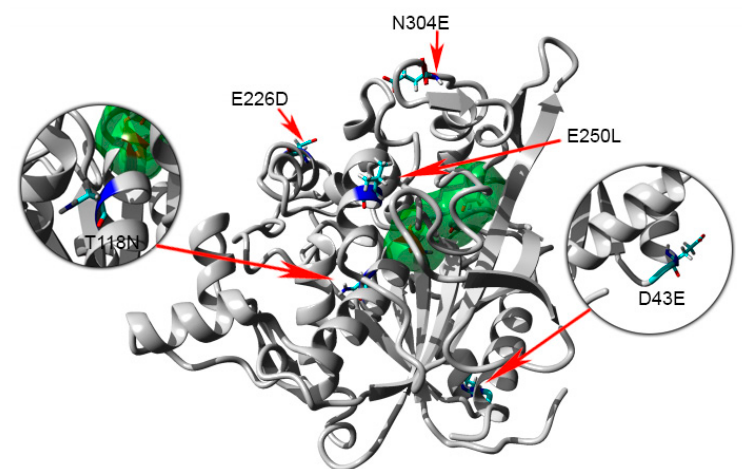
Figure 10. Structure of predicted structure of 5M mutant lipase with mutation location sites. The catalytic triad residues (Ser113, Asp317 and His358) are colored as green surface. Mutated residues (Glu43, Asn118, Asp226, Glu250 and Glu304) colored by element.